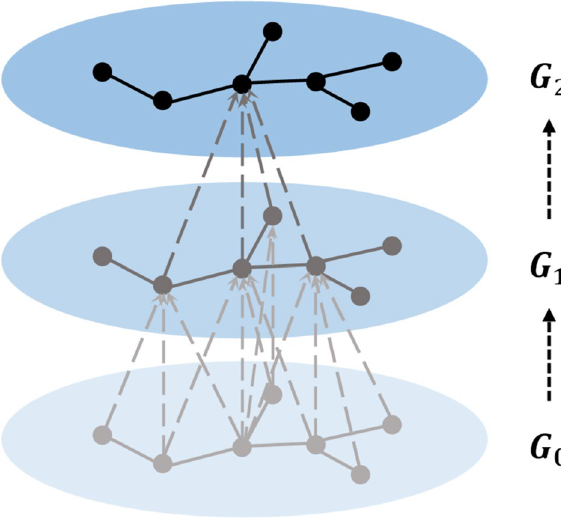
Figure 3. Schematic of aggregate node information when k = 2 .